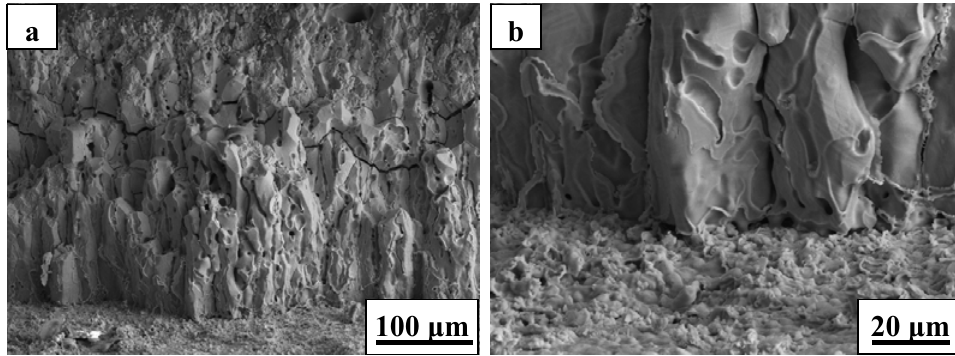
Figure 4. SEM micrographs of the oxide scale for ZS10 after ablation under condition 1: ( a ) low magnification; ( b ) high